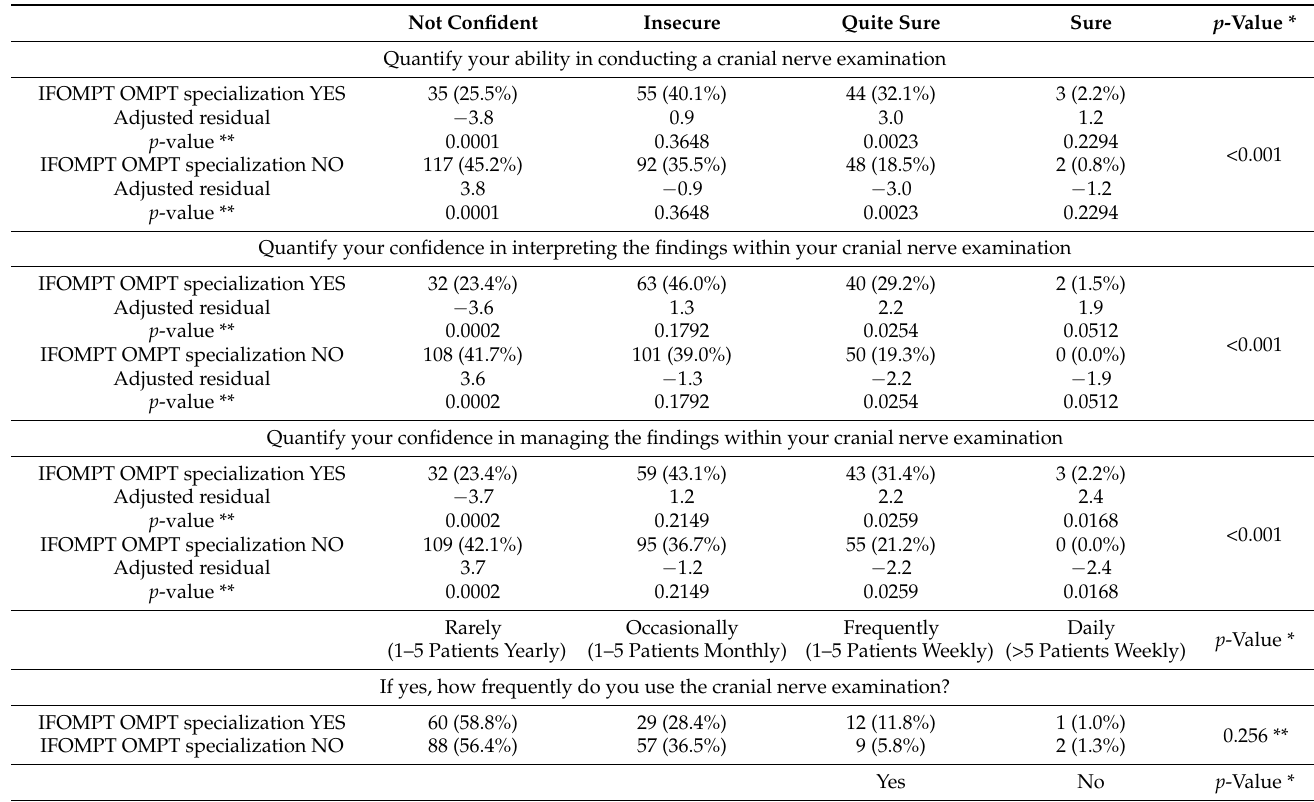
Table 2. Response to each survey questions, summarized for IFOMPT OMPT